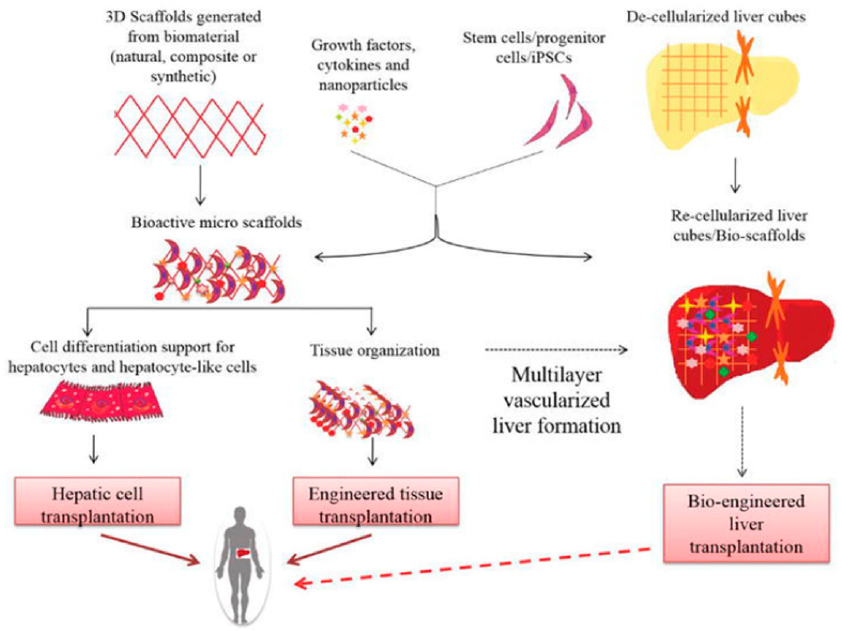
Figure 4. Schematic diagram of liver tissue engineering. Solid lines show already ongoing approaches, whereas dotted lines indicate proposed mechanisms [59].